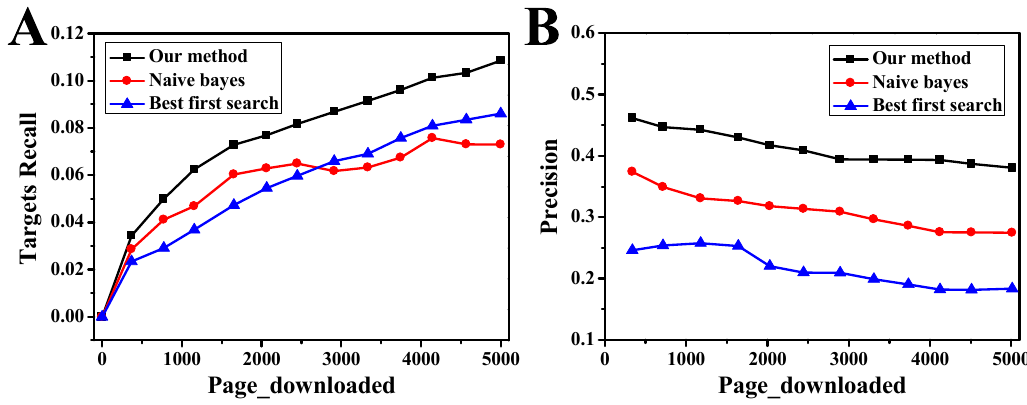
Figure 6. ( A , B ) The recall rate and accuracy rate comparison of crawling network text. Figure 6. ( A-B ) The recall rate and accuracy rate comparison of crawling network text.